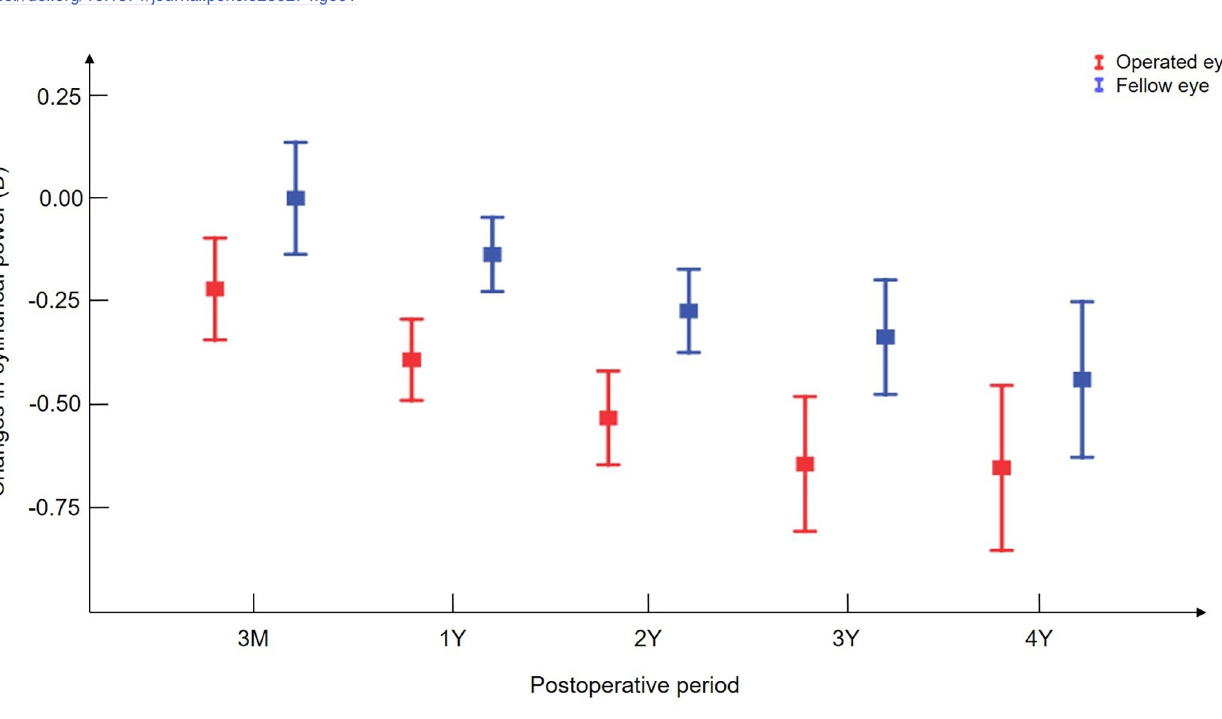
PLOS ONE | https://doi.org/10.1371/journal.pone.0280274 January 12,